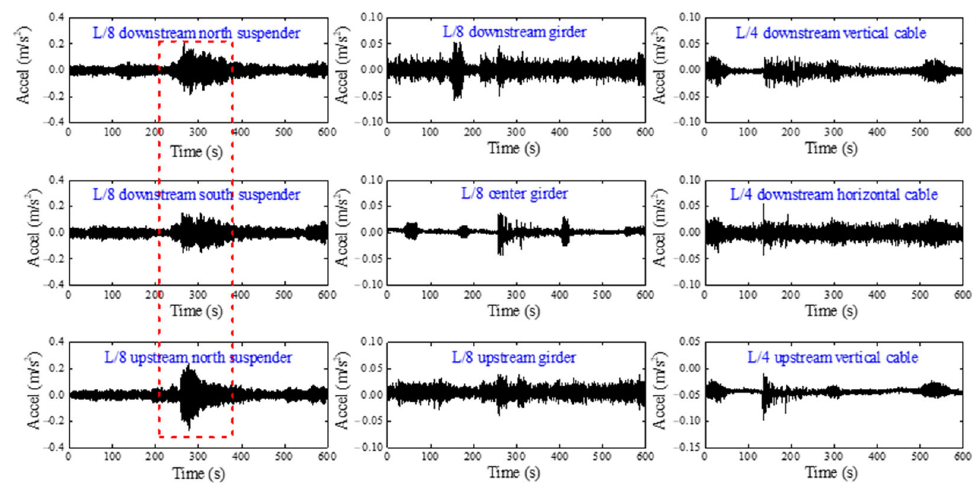
Figure 10. The acceleration data under ship collision of Jiangyin Bridge.